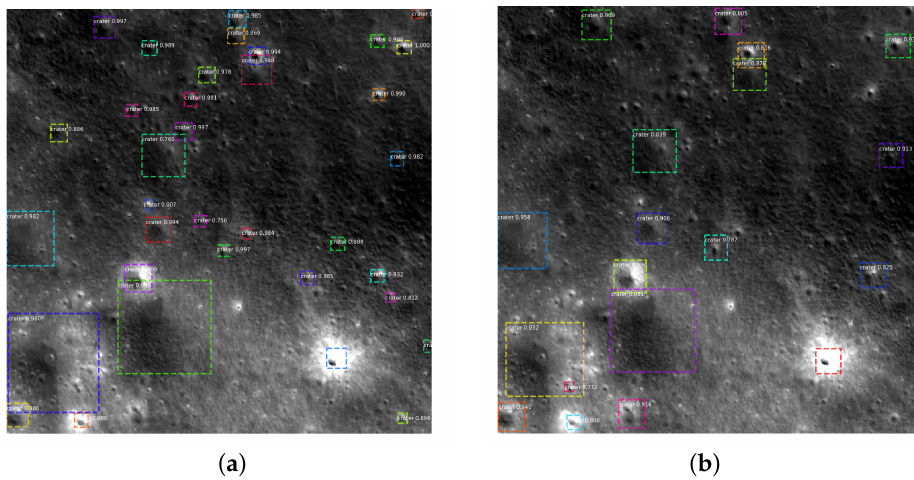
Figure 11. Difference between no-Mask R-CNN and Crater R-CNN with TTSN. The detection results of Crater R-CNN with TTSN ( a ) and no-Mask R-CNN ( b ) are shown. It can be seen that the crater size detected by no-Mask R-CNN was larger than the actual crater size, and the number of detections was also smaller than that of Crater R-CNN with